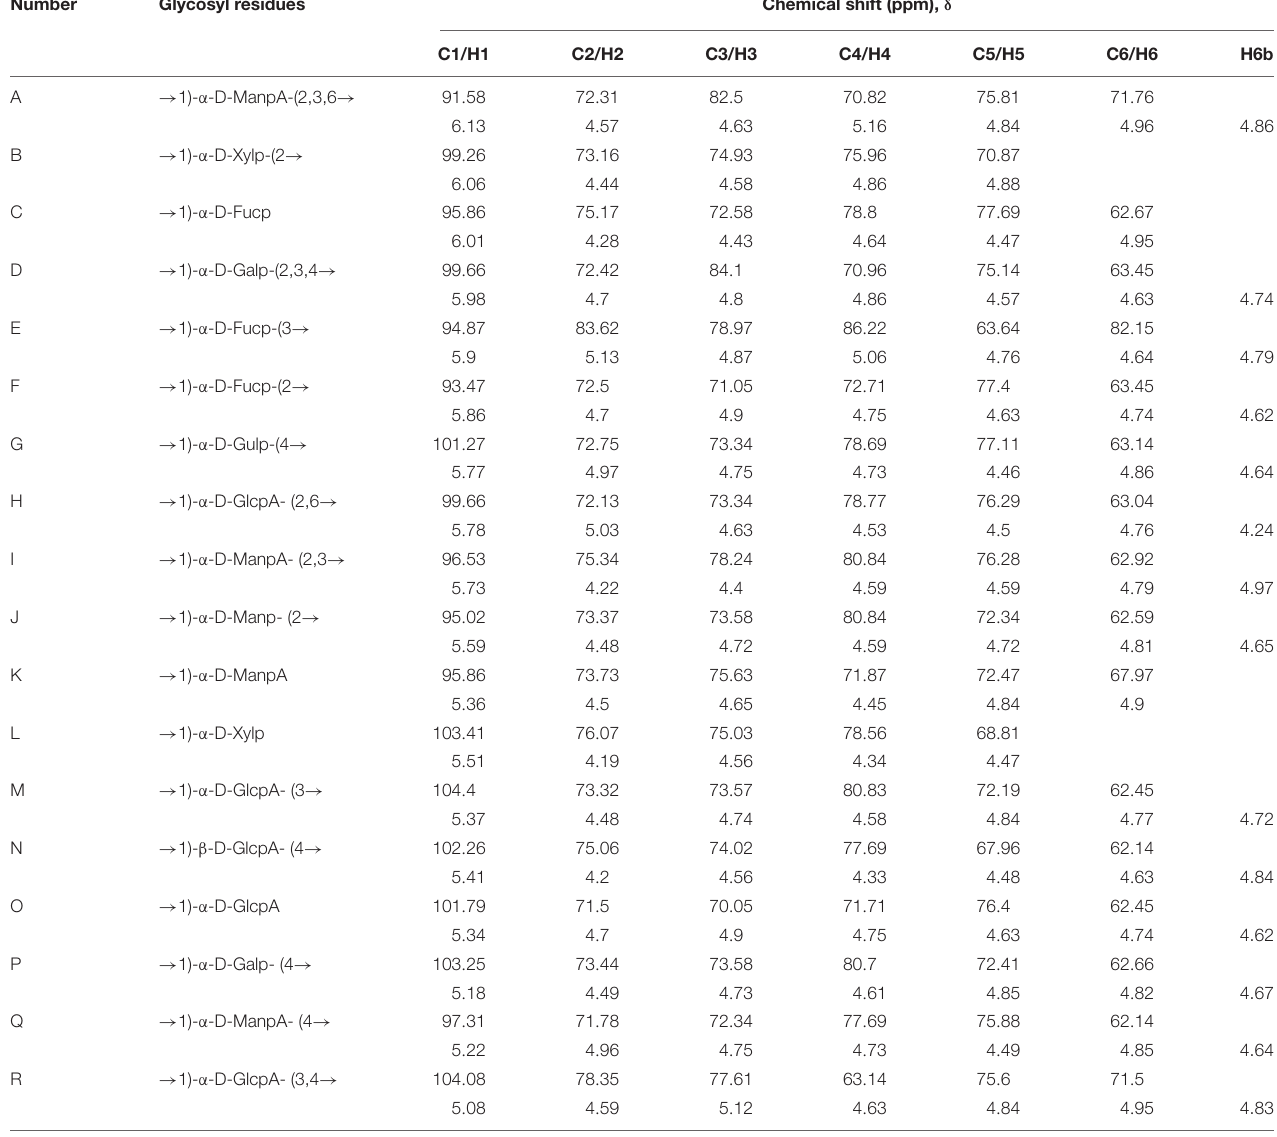
TABLE 4 | The 1 H and 13 C nuclear magnetic resonance (NMR) chemical shifts of LJPS recorded in D 2 O at 25 ◦ C. Number Glycosyl residues Chemical shift (ppm), δ C1/H1 C2/H2